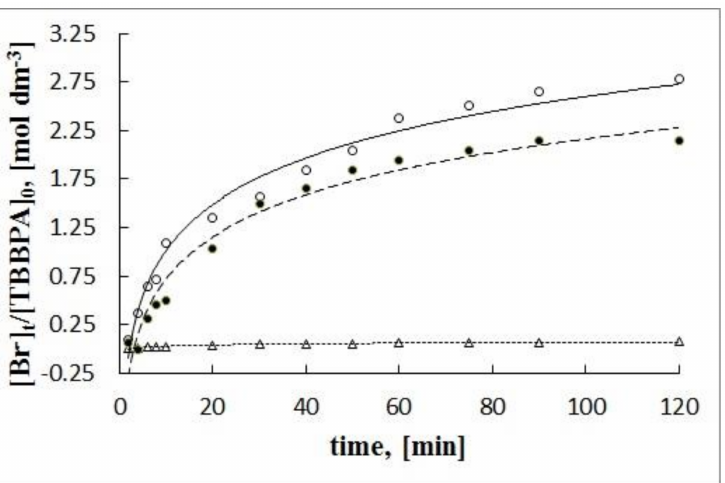
Figure 7. Relative concentrations of Br − vs. time profile obtained upon illumination of air-saturated aqueous suspensions, pH 10, 2.0 × 10 − 4 mol dm − 3 of substrate III. The filled circle ( • ) represents the compounds in the S0-catalyst suspensions, the open circle (o) in the S1-catalyst suspension, while open triangle ( ∆ ) in the S2-catalyst